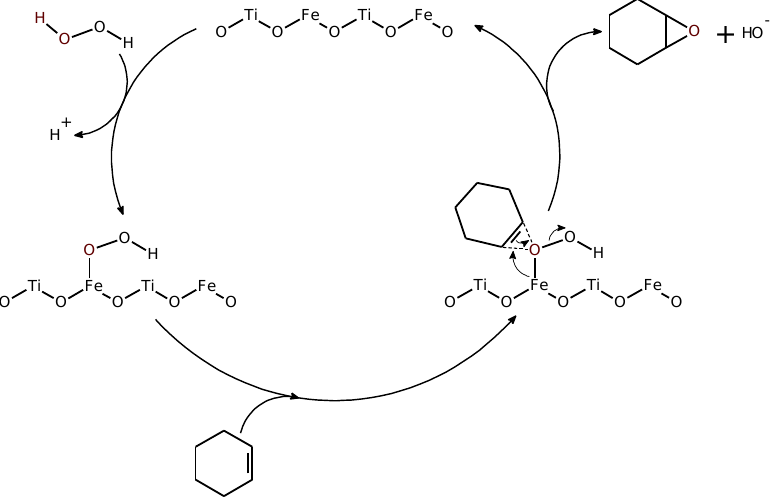
Figure 7. Proposed pathway for the epoxidation of cyclohexene over iron-doped titanium dioxide photocatalysts.